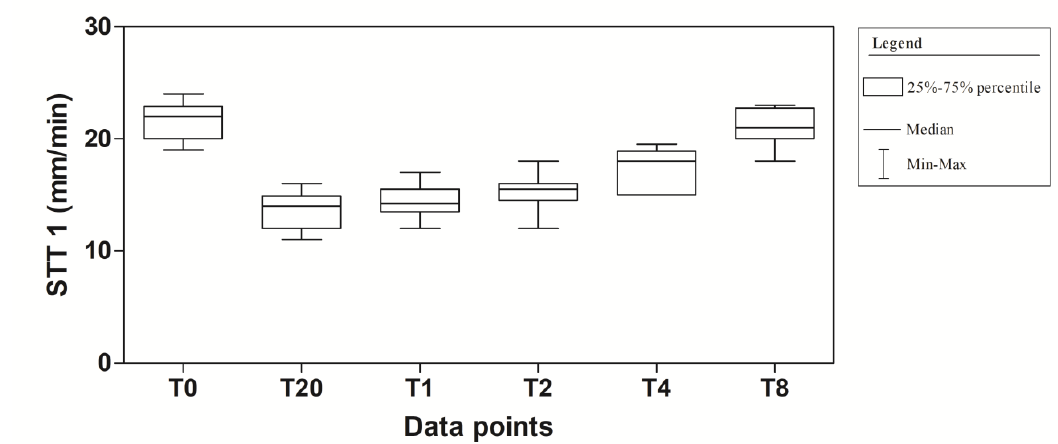
Figure 1. Descriptive statistic (Median, Minimum (Min), Maximum (Max), 25% and 75% Percentiles) of tear production (mm/min) of 10 dogs ( n = 20 eyes) subjected to dexmedetomidine sedation.